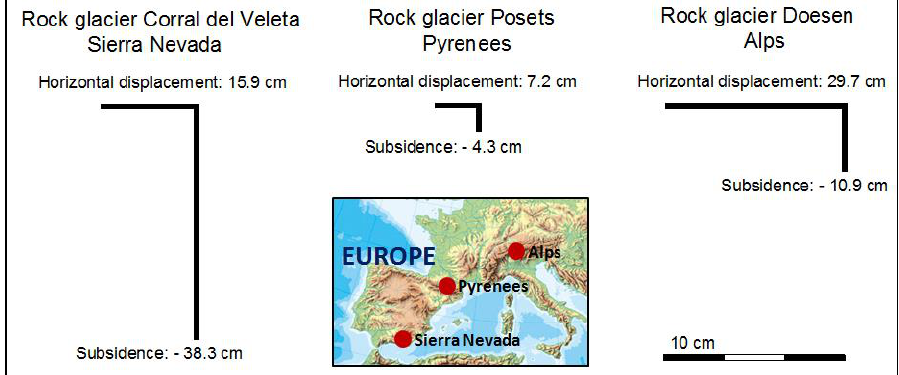
Figure 10. Planimetric and altimetric comparison of mean displacement of the rock glaciers of Doesen in the Alps, Posets in Pyrenees and Corral del Veleta in Sierra Nevada.